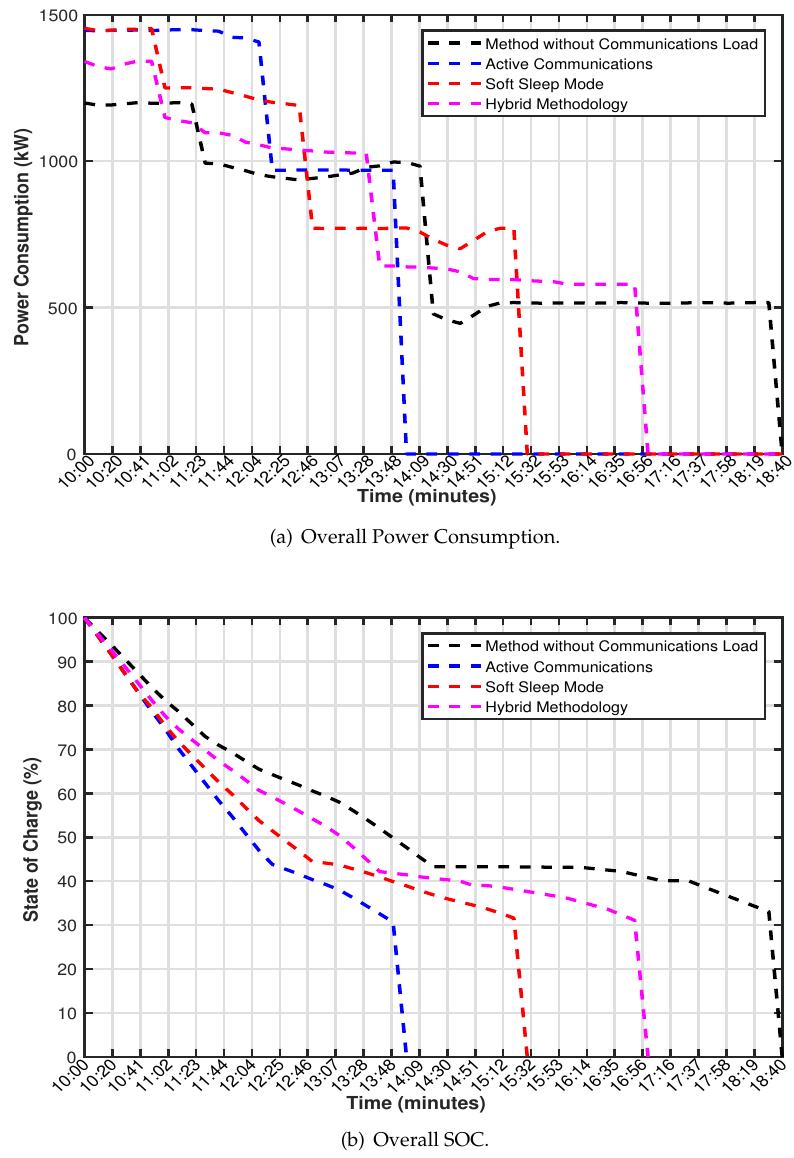
Figure 2. ( a ) comparison of power consumption for several methodologies; ( b ) comparison of state of charge for several